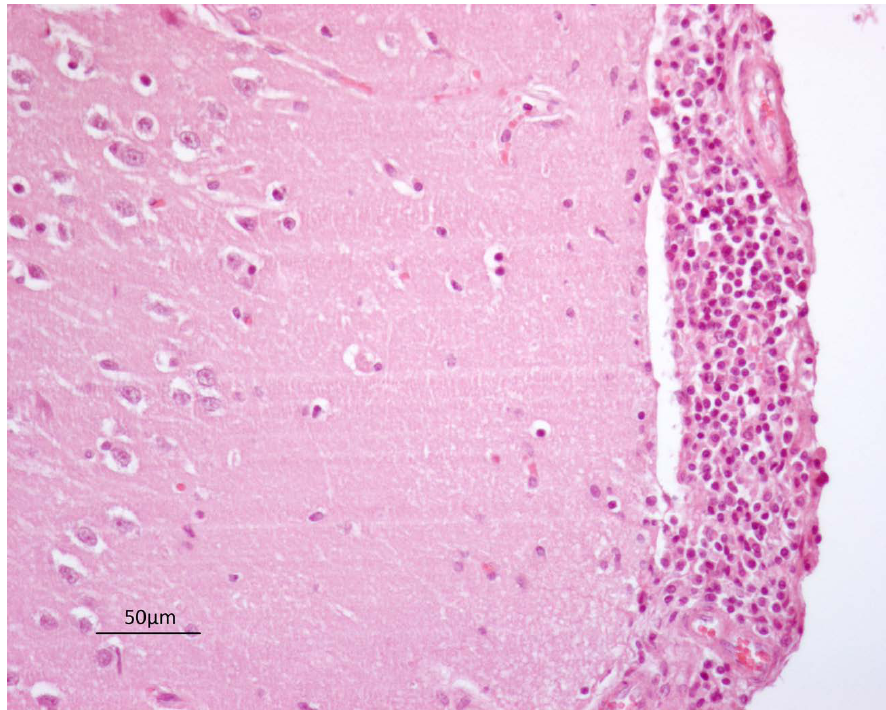
Figure 2. Brain. Mild, multifocal to coalescing infiltration of lymphocytes, plasma cells, and occa- sional histiocytes within the leptomeninges (20 × ).